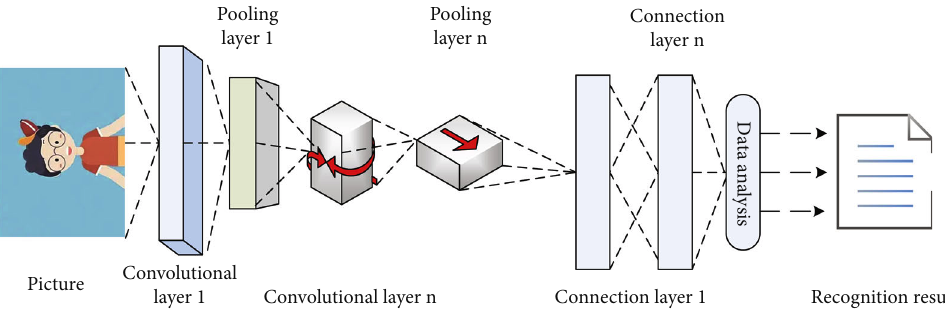
Figure 2: Architecture of ROI-KNN convolutional neural